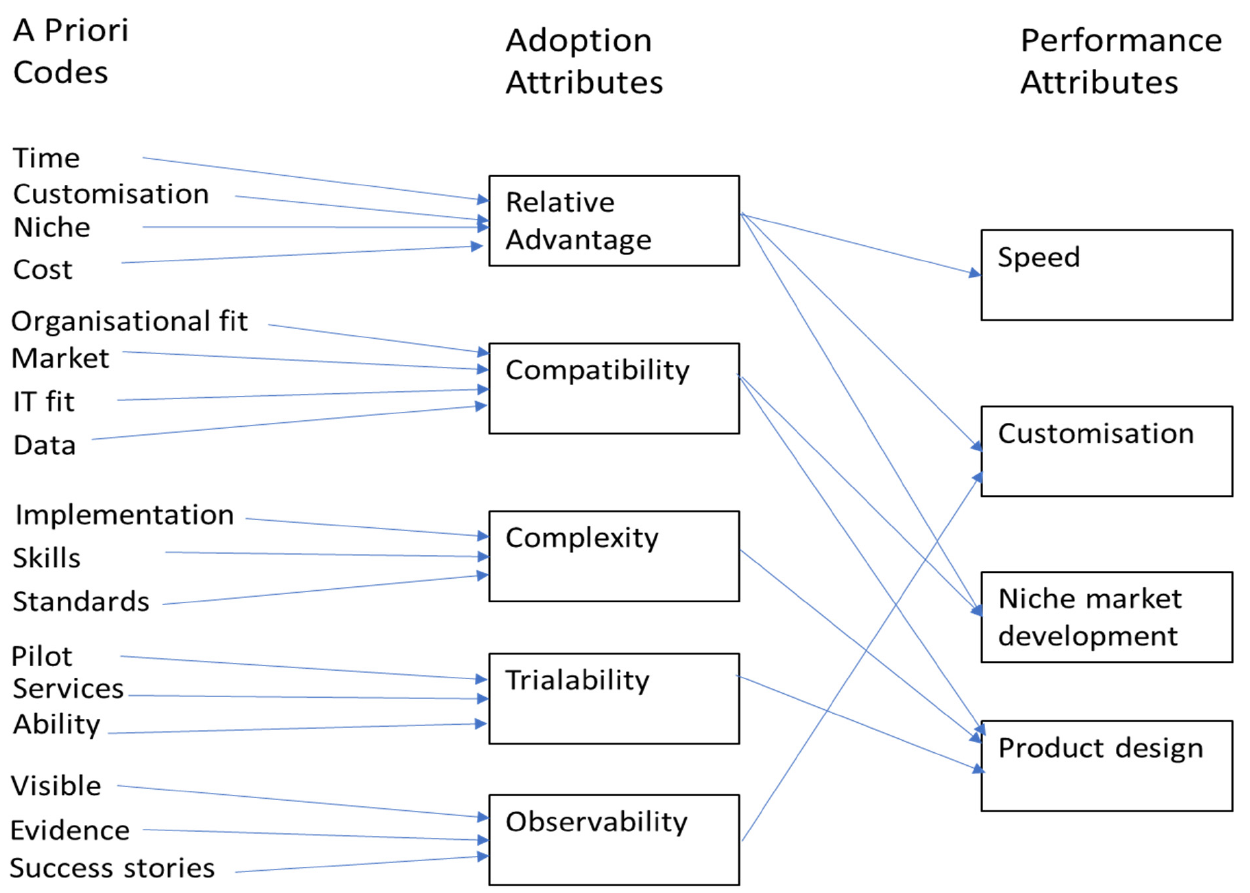
Figure 1. Overview of AM data structure.